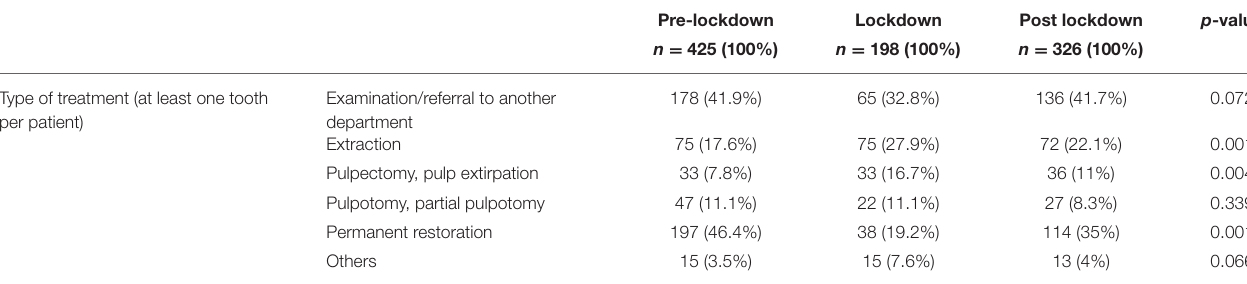
TABLE 2 | Treatments provided according to periods (including dental emergencies and scheduled